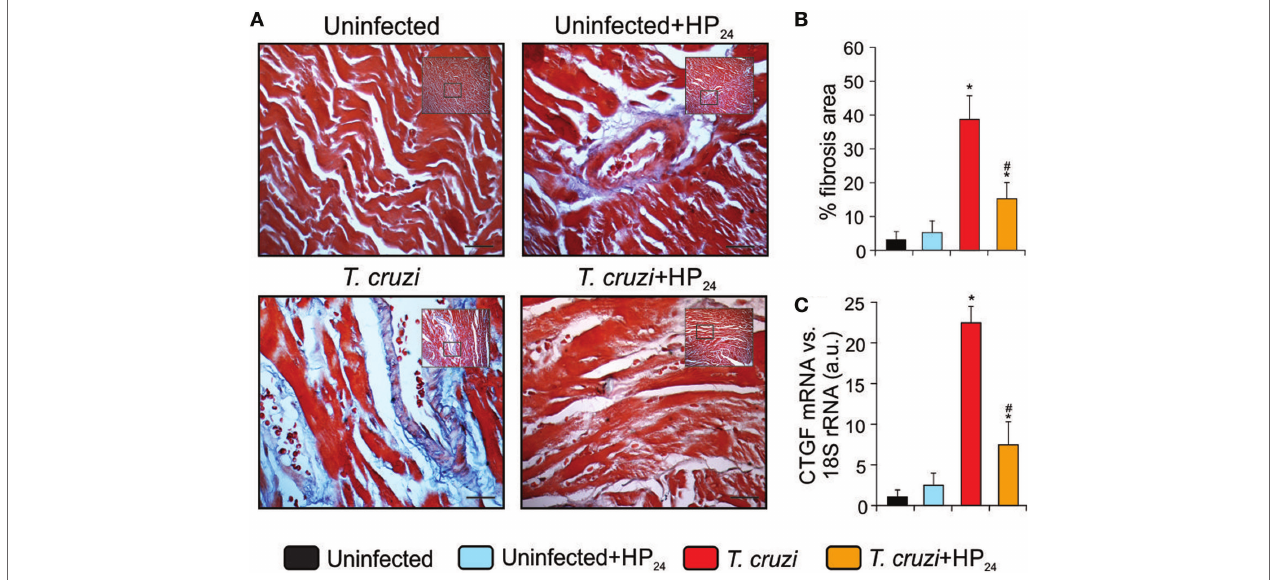
FigUre 7 | Reduction of heart fibrosis by HP 24 in Trypanosoma cruzi -infected mice (a) .Collagen deposits in heart sections of the experimental groups were assessed using Masson’s trichrome (bar: 100 µm). (B) The bar graph shows the percentage of area with fibrosis. (c) Connective tissue growth factor (CTGF) mRNA expression was analyzed by quantitative real-time reverse-transcriptase polymerase chain reaction in heart homogenates from all experimental groups. Results were normalized against 18S rRNA. All studies were performed at 10 dpi. Results represent the mean ± SEM of three independent experiments (five mice per group). * P < 0.05 vs. uninfected mice, # P < 0.05 vs. T. cruzi -infected